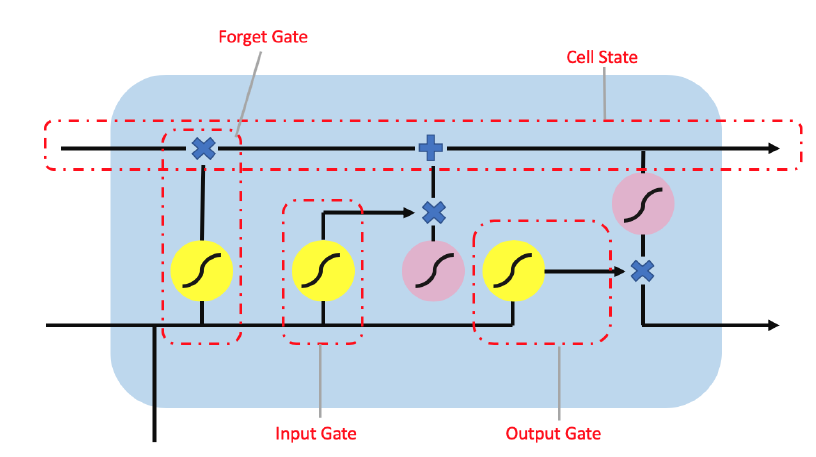
Figure 5. The long short-term memory (LSTM) unit contain a forget gate, output gate and input gate. The yellow circle represents the sigmoid activation function while the pink circle represents a tanh activation function. Additionally, the ”x” and “+” symbols are the element-wise multiplication and addition operator.